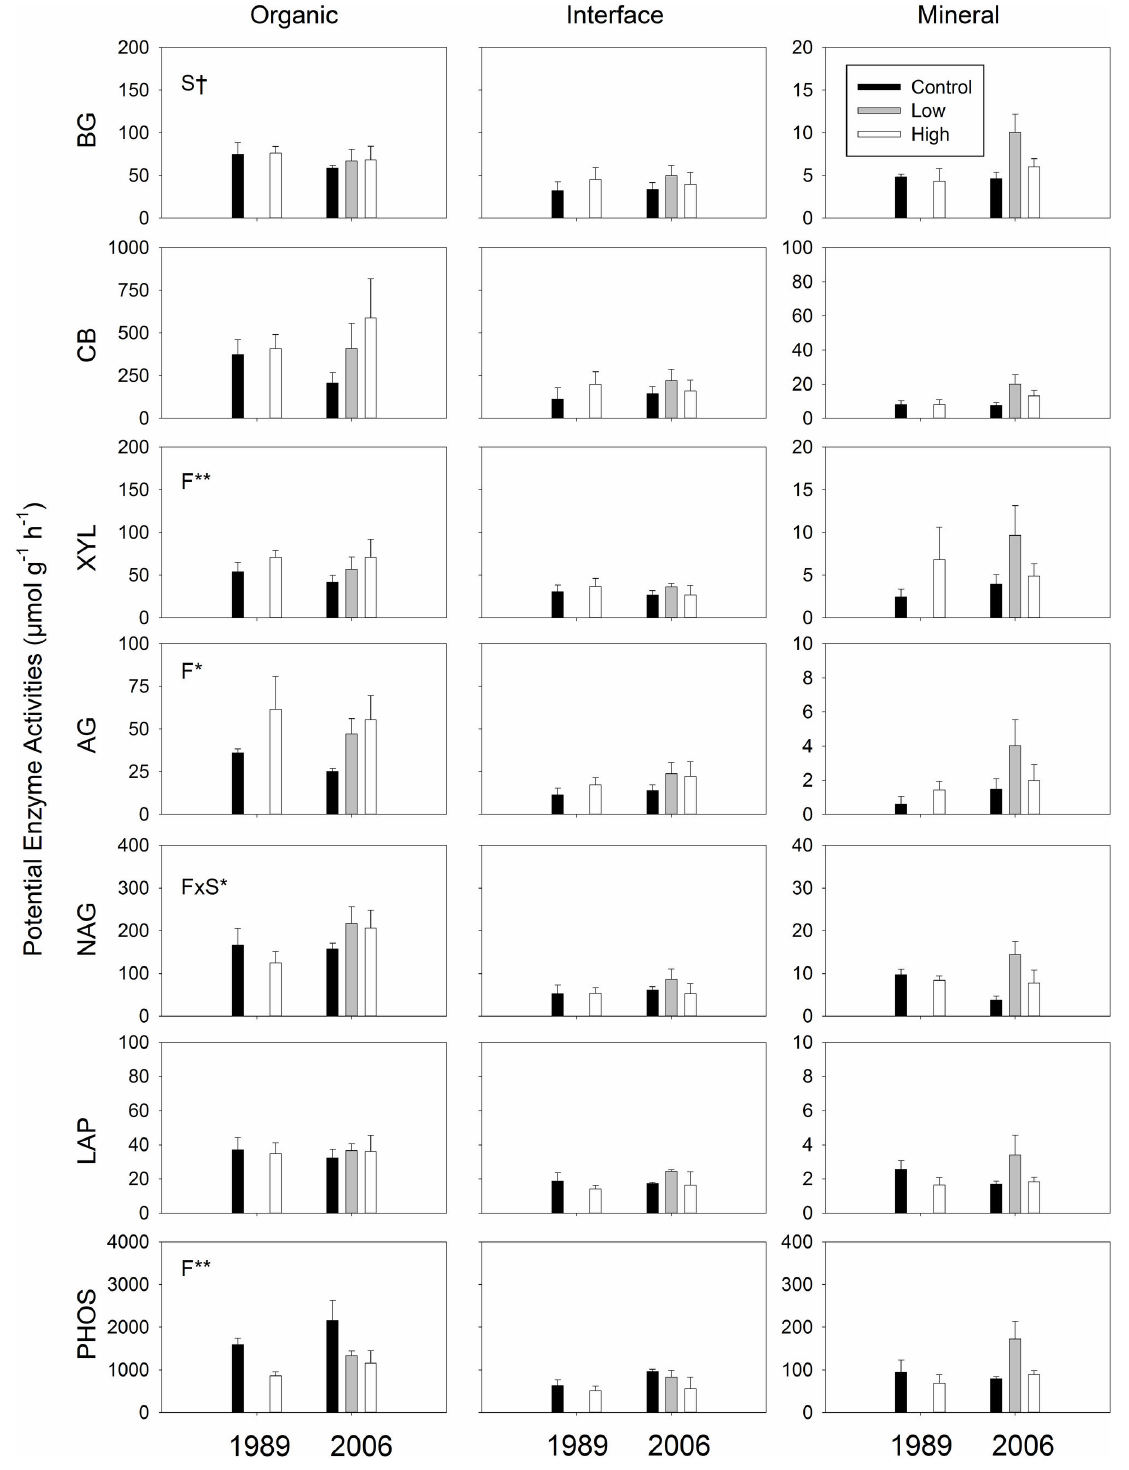
Figure 2. Potential enzyme activities in the three soil profiles, incubated at 15 °C. The scales of y-axes for organic and interface soils are identical. Statistically significant effects found by mixed-effect ANOVA are shown in panels: F; fertilization treatment (control, low and high fertilizations), S; site (i.e., 1989 and 2006 sites), and F×S; interaction between F and S. Symbols indicate: †; p ≤ 0.10, *; p ≤ 0.05, **; p ≤ 0.01. doi: 10.1371/journal.pone.0077212.g002 PLOS ONE | www.plosone.org 5 October 2013 | Volume 8 | Issue 10 |